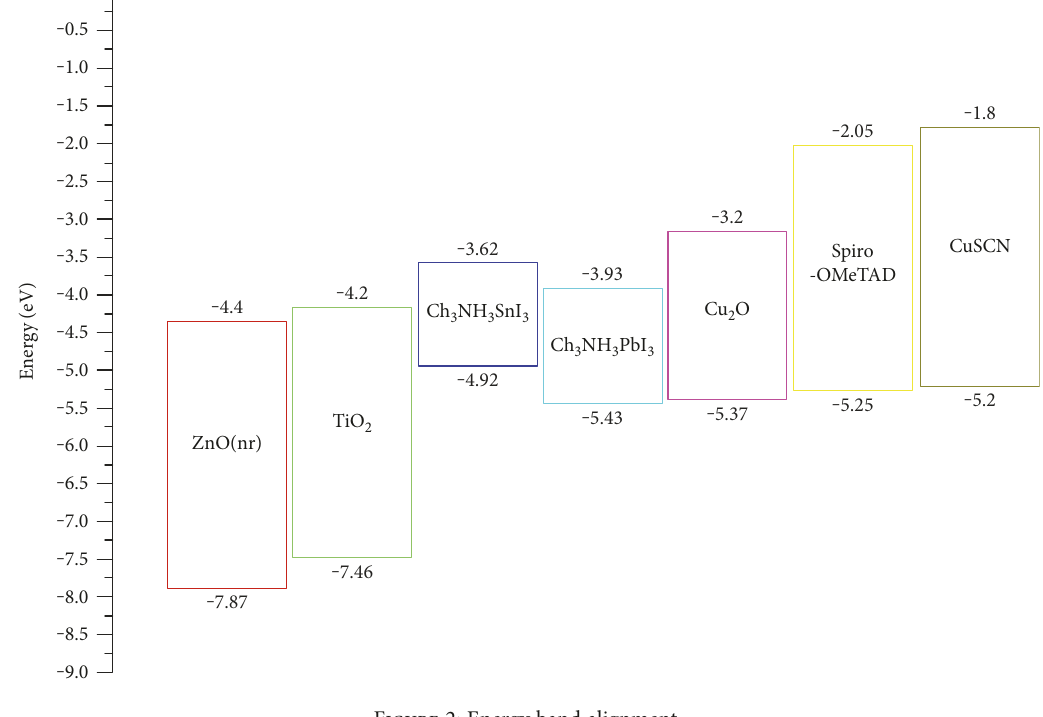
Figure 2: Energy band